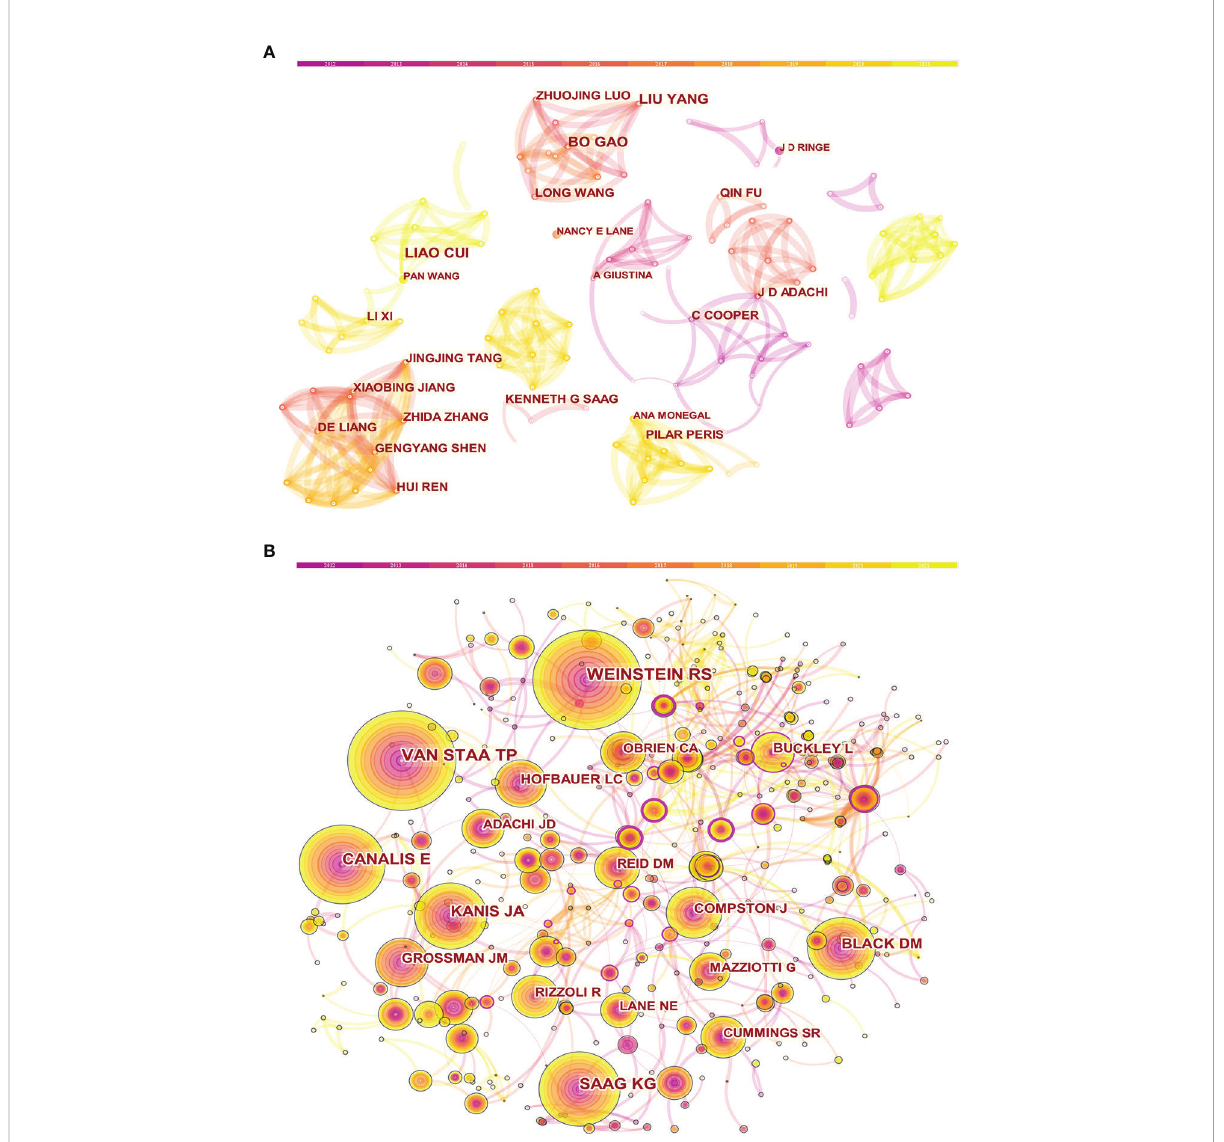
FIGURE 4 Visual analysis of authors. (A) Collaboration network of co-authors. (B) Network visualization map of cited